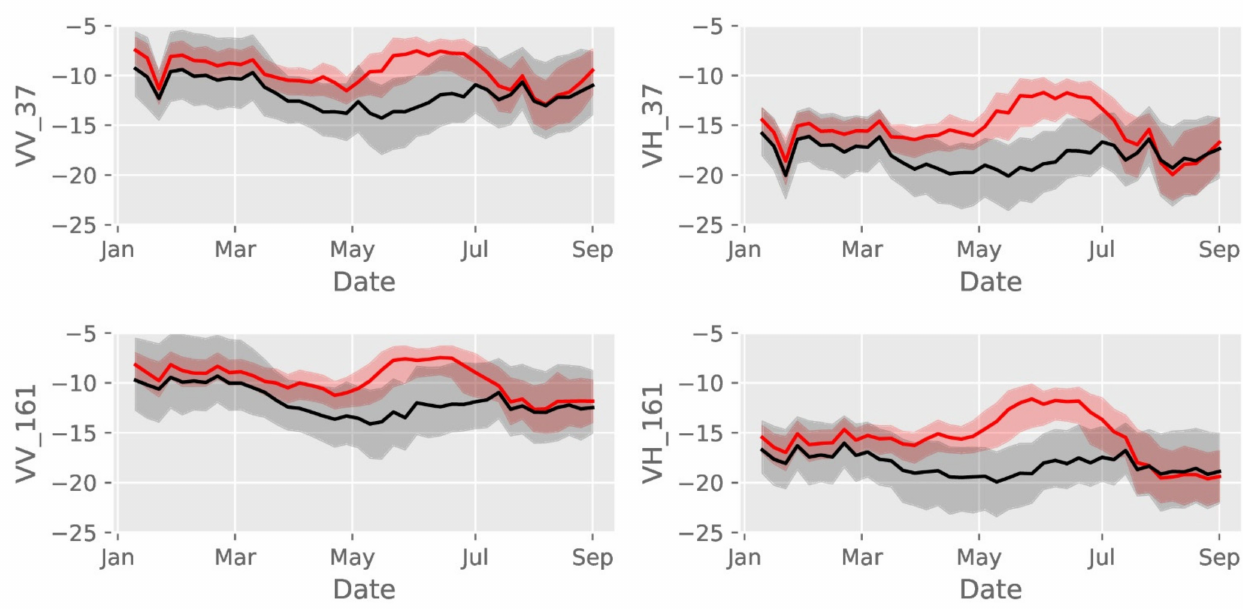
Figure 2. Evolution of the mean and interval between percentiles 5 and 95 of the backscattering coefficient for winter rape (in red) and all the crops (in